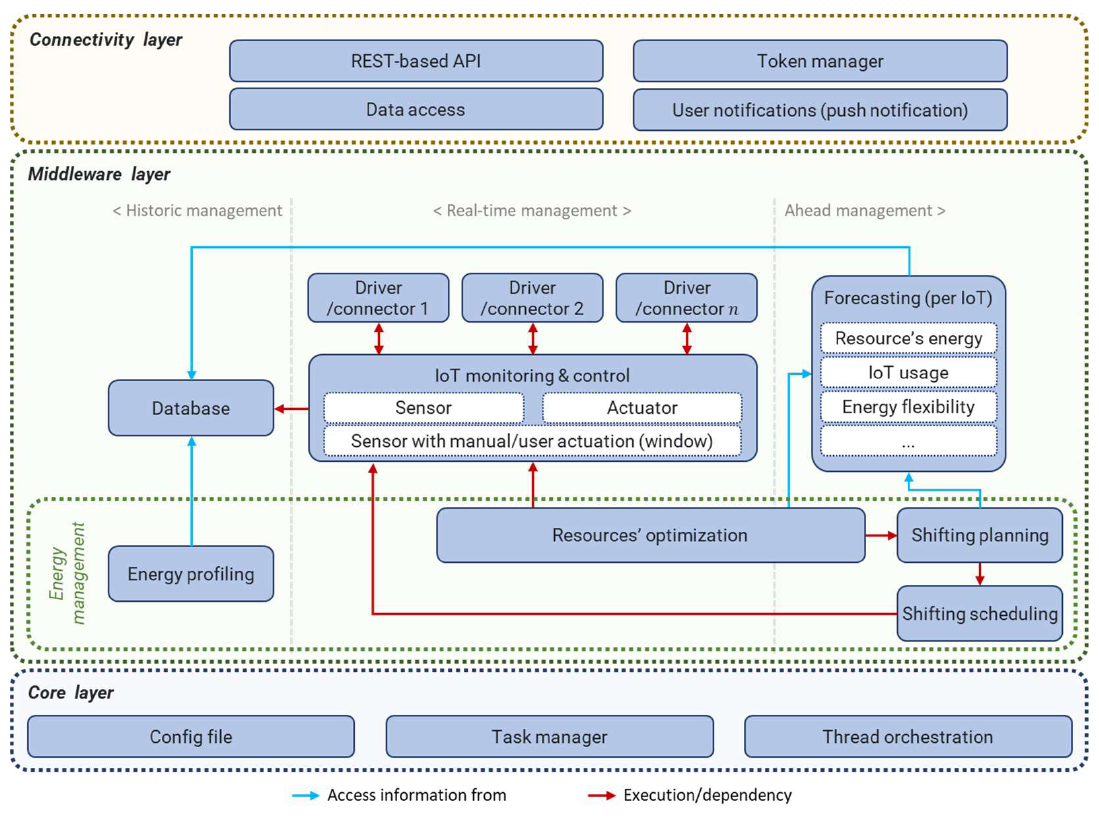
Figure 1. Software Architecture.